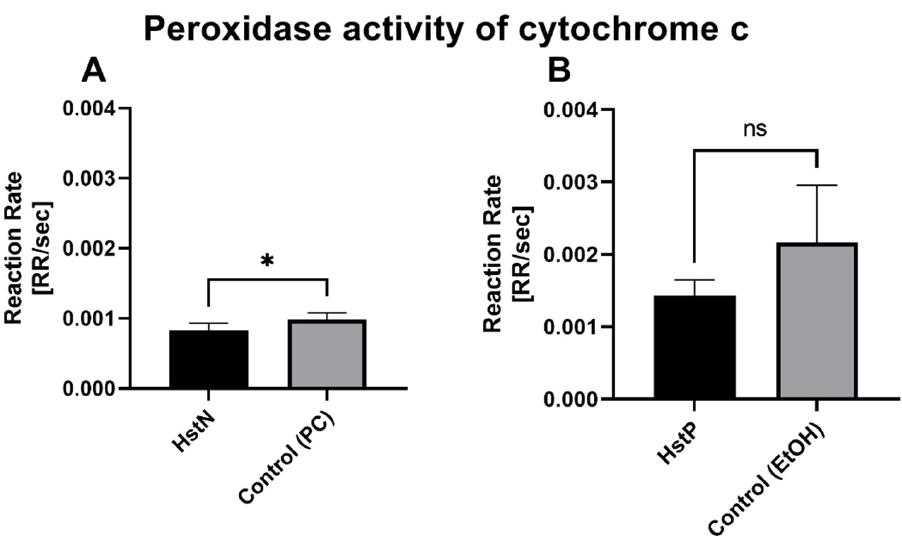
Figure 8. Effects of HstN and HstP on peroxidase activity of cytochrome c: ( A ) incubated with HstN, with PC as control (N = 6), and ( B ) incubated with HstP, with ethanol as control (N = 5). Respective mean values ± SD are shown. Significance was determined with unpaired Student’s t-test. * p < 0.05. HstN, hesperetin nanocrystal; HstP, hesperetin in pure form; PC, PlantaCare; EtOH, ethanol .